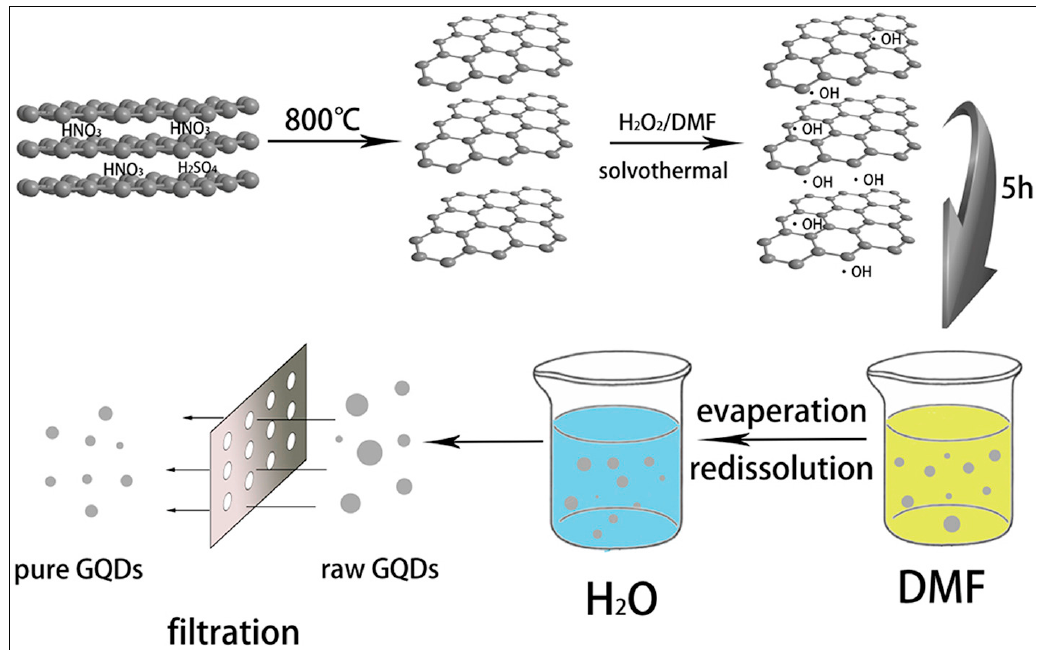
Figure 3. Fabrication of graphene quantum dots by hydrogen peroxide. Reprinted with permission from Ref. [39].